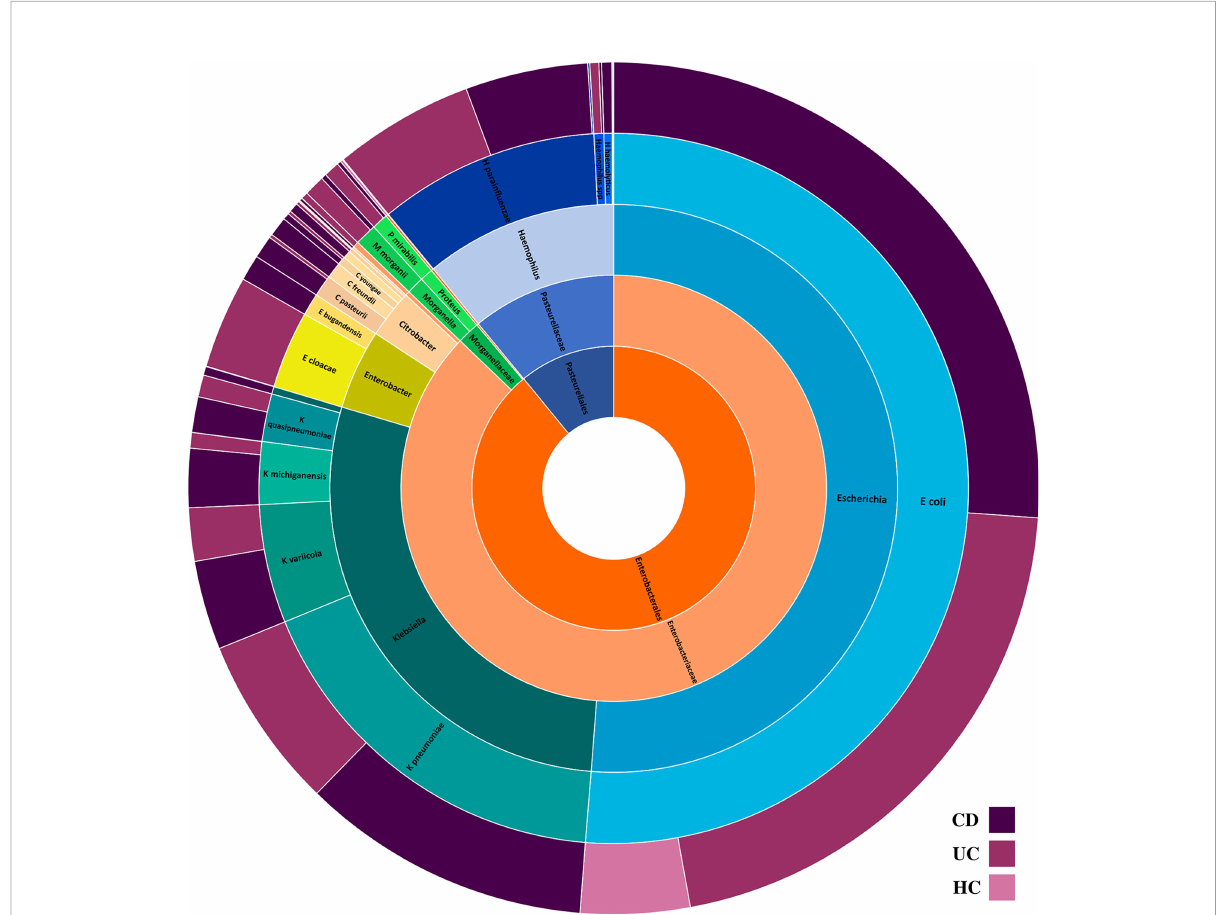
FIGURE 1 The composition of intestinal Proteobacteria in the CD, UC, and HC groups. Different colors represent different taxa, blue for Escherichia spp., teal for Klebsiella spp., yellowgreen for Enterobacter spp., peach for Citrobacter spp., green for Morganella and Proteus spp., light orange for Enterobacteriaceae family, dark orange for Enterobacteriales order, and steel blue for Pasteurellales